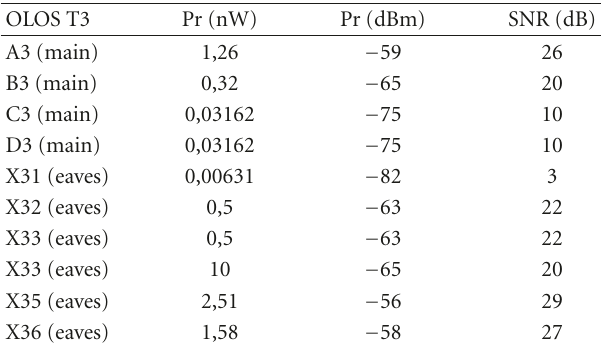
Table 1: Average received power and SNR for OLOS-1 (T3) scheme.